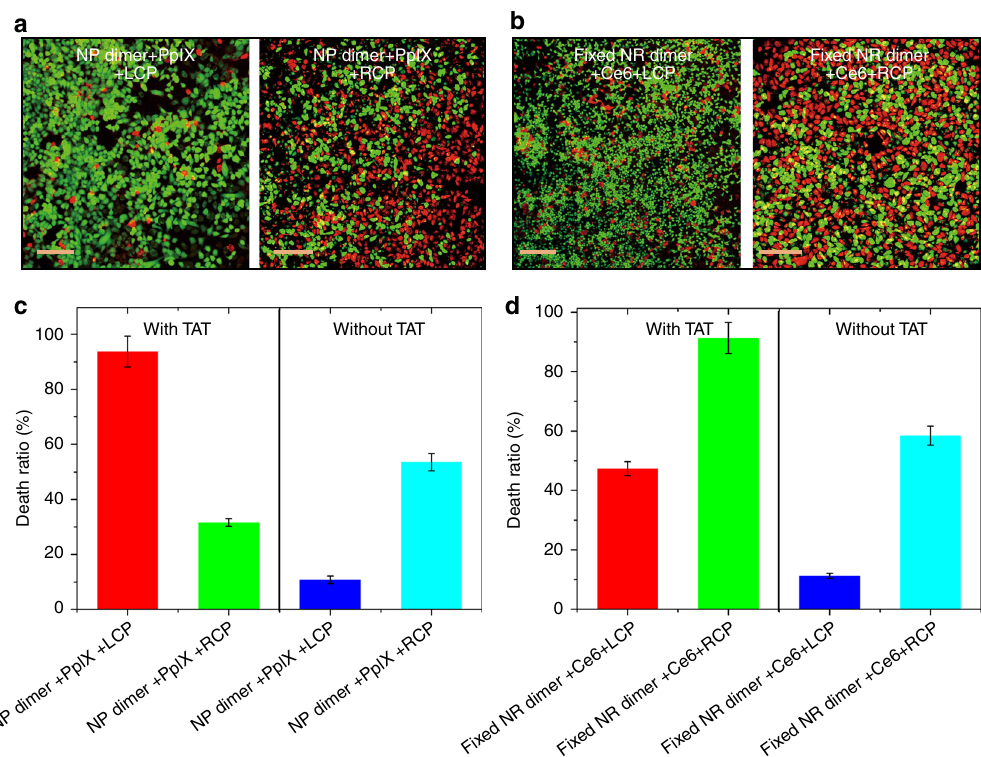
Fig. 5 Cell penetrating peptide effect for photodynamic therapy. a , b Live (green, FITC)/dead (red, Texas Red) assays with confocal microscopy for adherent HeLa cells after 30 min illumination under different polarization conditions for NP dimers (without cell penetrating peptides labeled on the NP surface and denoted by without TAT) with 532 nm photons ( a ) and NR dimers (without cell penetrating peptides labeled on the NR surface and denoted by without TAT) with 660 nm photons ( b ), respectively. c , d The death ratio of HeLa cells incubated with ( c ) NP dimers, ( d ) NR dimers under different polarized light irradiation determined by MTT assay. The NP or NR dimers with/without cell penetrating peptides modi fi ed on the surface were denoted by with TAT/without TAT. Scale bar: 200 μ m. The error bars correspond to the standard error of the mean ( n =